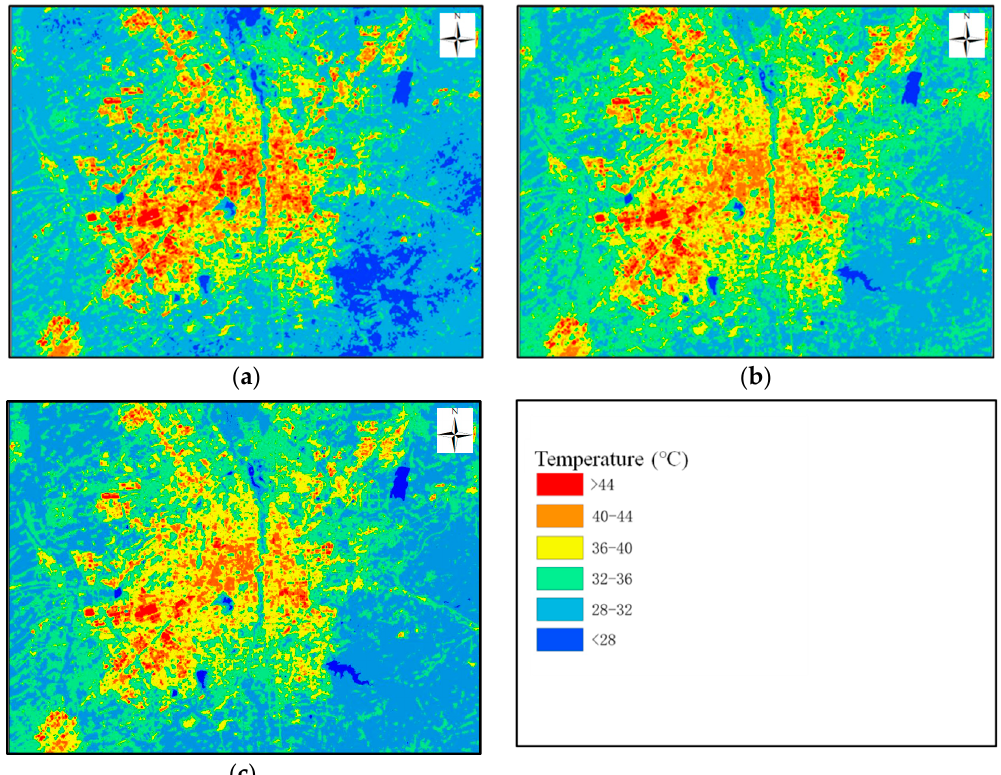
Figure 14. Land surface temperature in Changchun City where ( a ) is a result of the MWA, ( b ) is the result of the SWA, and ( c ) is the result of the SC method.